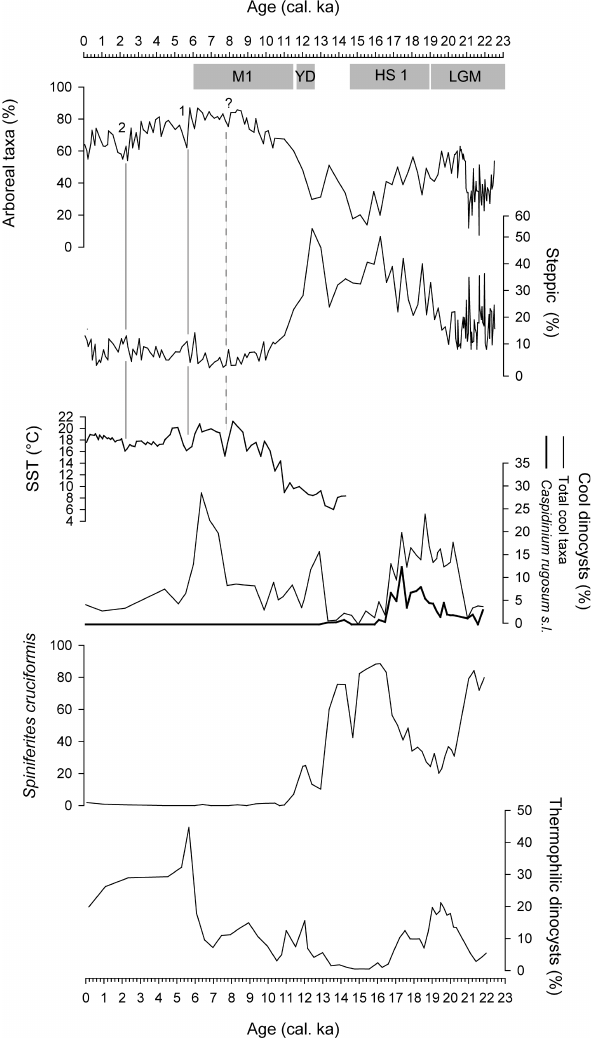
Fig. 4. Pollen percentages, dinocysts percentages and sea-surface temperature (SST) for core MD01-2430. Arboreal taxa include all trees and shrubs except Hippopha¨e , Ephedra distachya type and E. fragilis type. Steppic includes Artemisia , Chenopodi- aceae, Ephedra distachya type and E. fragilis type. Alkenone de- rived sea-surface temperatures (SST) (Vidal et al., 2010). Ther- mophilic dinocysts include: Tuberculodinium vancampoae , Tecta- todinium pellitum , Spiniferites mirabilis , Spiniferites delicatus , Lin- gulodinium machaerophorum , Polysphaeridium zoharyi , Opercu- lodinium israelianum , and Stelladinium stellatum ; cool dinocysts include: Pentapharsodinium dalei , Bitectatodinium tepikiense s.l., Caspidinium rugosum s.l. and Spiniferites elongatus s.l. (Londeix et al., 2009). Numbers 1 and 2 indicate forest setbacks. Grey boxes indicate major climatic shifts: LGM (Last Glacial Maximum) which last from 23–19calka (Mix et al., 2001), HS1 (Heinrich Stadial 1) from ca. 19–15calka (Sanchez Go ˜ ni and Harrison, 2010; Stanford et al., 2011), YD (Younger Dryas or GS-1) from ca. 12.7–11.7calka (Steffensen et al., 2008) and M1 from ca. 7–11.5calka (Vidal et al.,